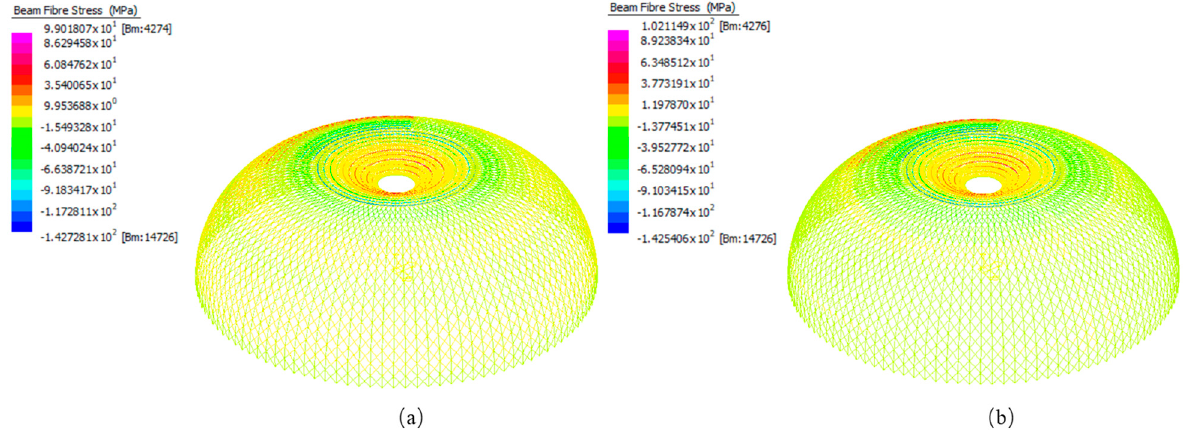
Figure 10. ( a ) Linear analysis of total fiber stress of straight member model under 1.35G; ( b ) nonlinear analysis of total fiber stress of straight member model under 1.35G.